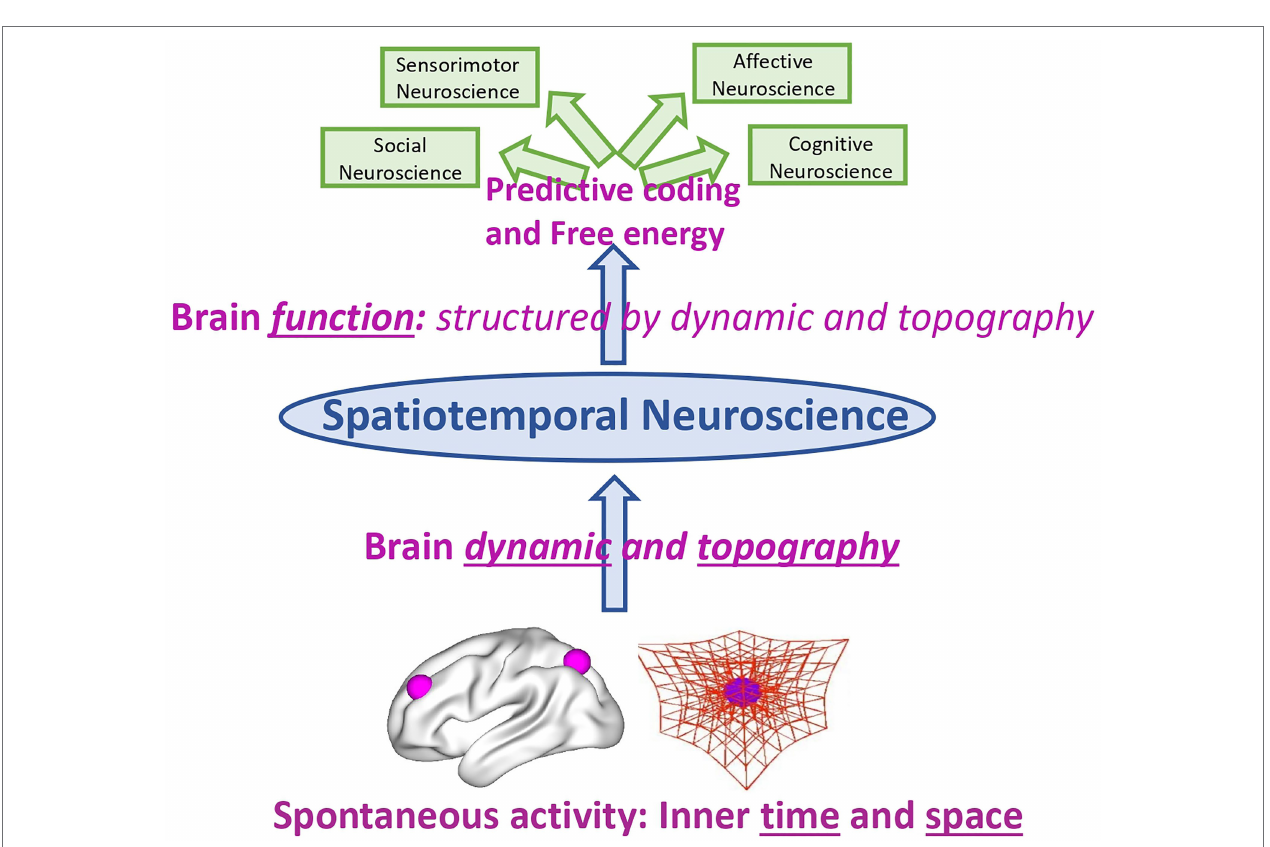
FIGURE 3 | Spatiotemporal Neuroscience – from brain dynamic and topography to brain